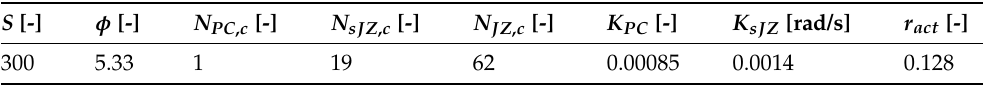
Figure 1. ( a ) The measured G (cid:48) (squares) and G (cid:48)(cid:48) (triangles) modulus for ω = 1 (red), 3 (black), and 10 (blue) rad/s, with 2 g aiyu seeds in 100 mL de-ionized water stirring for 1400 rpm and 60 min. The experimental time is normalized by t gel = 4390, 4500, 4750 s for ω = 1, 3, and 10 rad/s, respectively. ( b ) The corresponding model predicted moduli profiles with k E = 10 − 4 s − 1 , k 1 = 50 M − 2 s − 1 , and the parameters in Table 1. The model time is normalized by t gel = 4800, 4820, 4860 s for ω = 1, 3, 10 rad/s, respectively. ( c ) The model predicted point-like crosslink contribution to G (cid:48)(cid:48) . Table 1. Model fitting parameters for the time evolution of G (cid:48) and G (cid:48)(cid:48) . N c , PC = 15,000 n c , PC / C 0 , N c , sJZ = 15,000 n c , sJZ / C 0 , and N c , JZ = 15,000 n c , JZ / C 0 are the estimated dimensionless critical percola- tion number of respective crosslinks per polymer chain, where 15,000 is the degree of